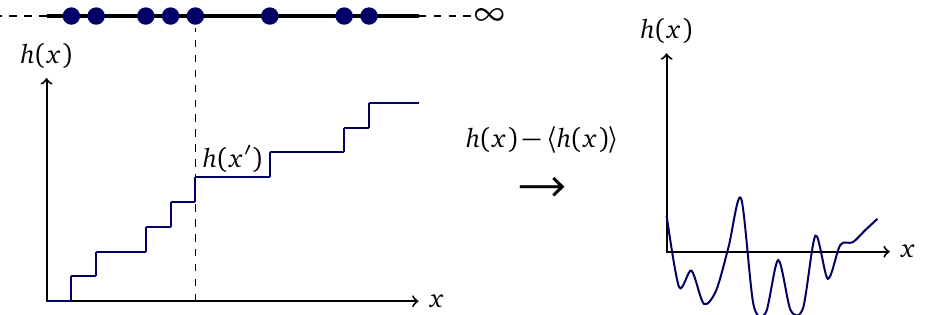
Figure 1: (left) Height function h ( x ) corresponding to a configuration of particles on the infinite line. (right) By shifting the height function, h ( x ) → h ( x ) − 〈 h ( x ) 〉 , one obtains a fluctuating field with zero